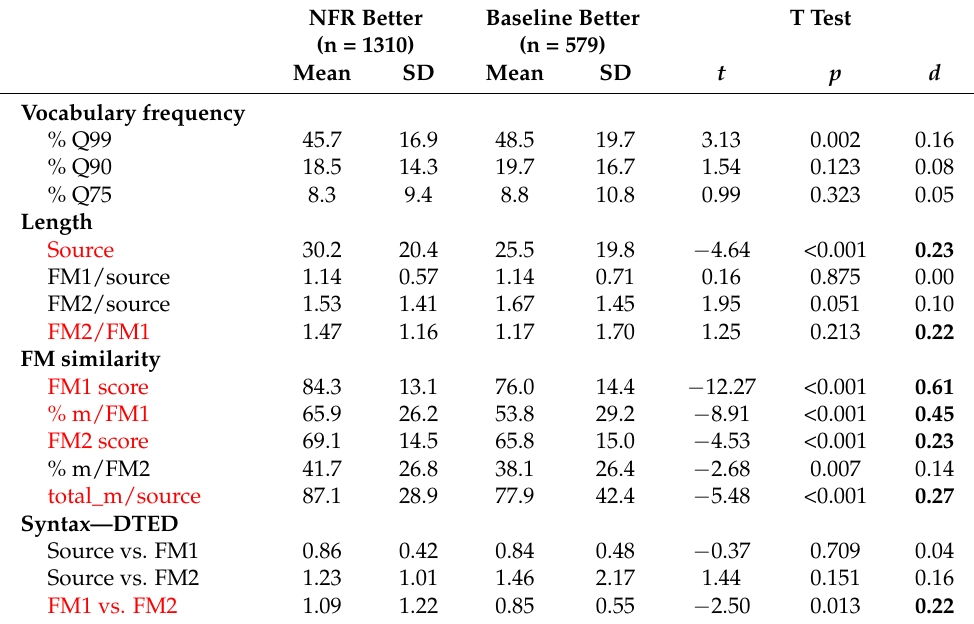
Table 13. Results feature analysis, including means and standard deviations (SD) per subset and t - and p -values of independent samples t -test, as well as Cohen’s d effect size. Features with effect sizes above 0.20 are indicated in red.